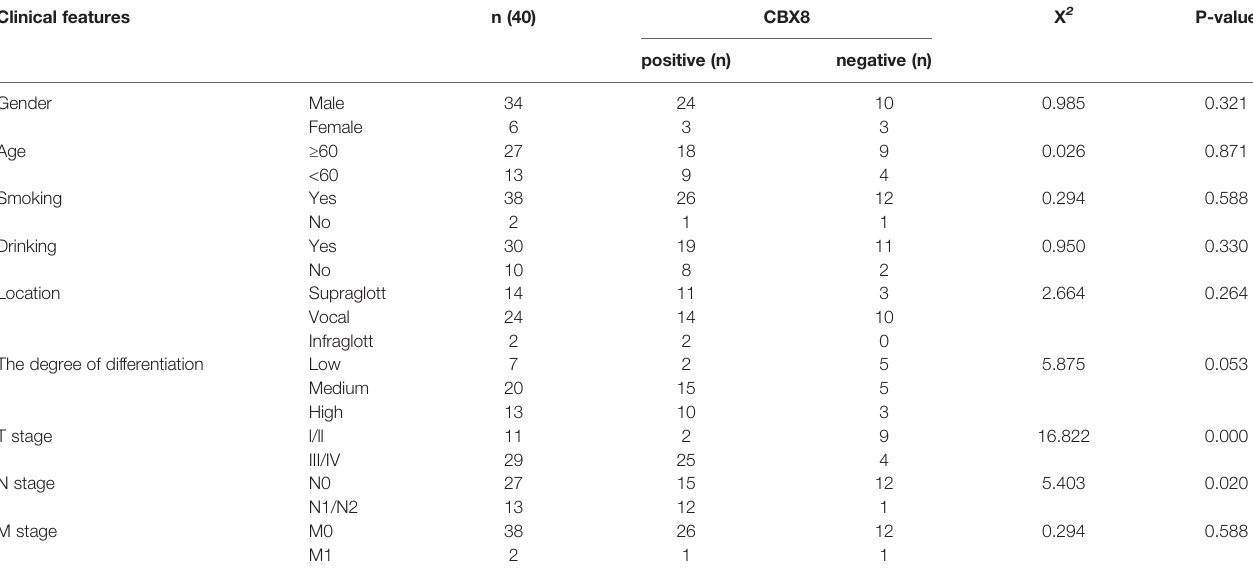
TABLE 2 | The relationship between CBX8 protein expression and clinicopathological features. Clinical